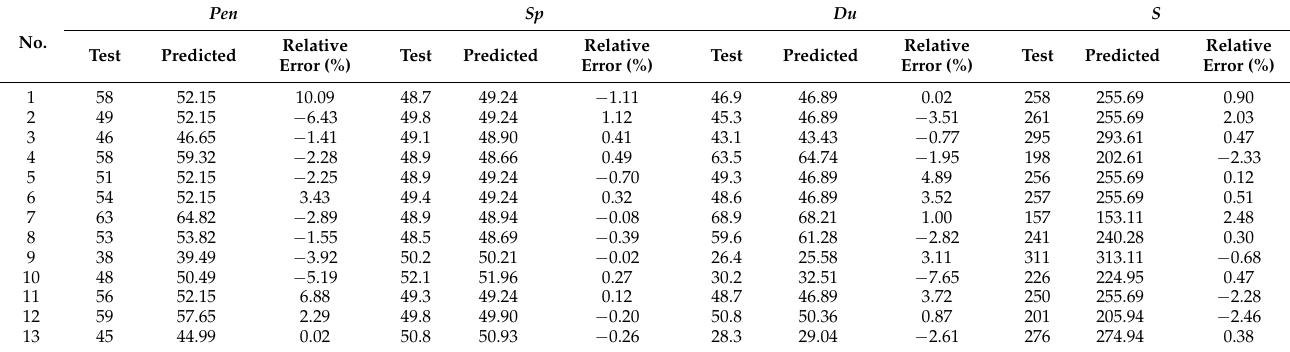
Table 6. Comparison of test results and model prediction